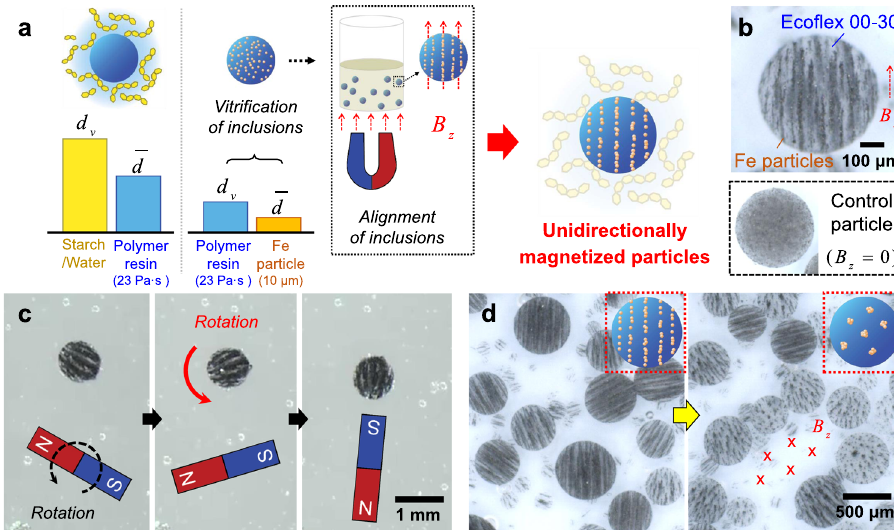
Fig. 5 Scalable programming of unidirectionally magnetized particles. a Manufacturing conditions for the composite droplets to evolve as unidirectionally magnetized particles. An external magnetic fi eld, B z forces previously vitri fi ed nanoparticle inclusions ( d v > (cid:1) d ) to align along the magnetic fl ux within the polymer droplet. b Optical micrographs of a unidirectionally magnetized particle and a control particle prepared without a magnetic fi eld. c Rotating motion of the single magnetized particle using an external magnetic fi eld, B z . d Collective actuated behavior of a group of the magnetized